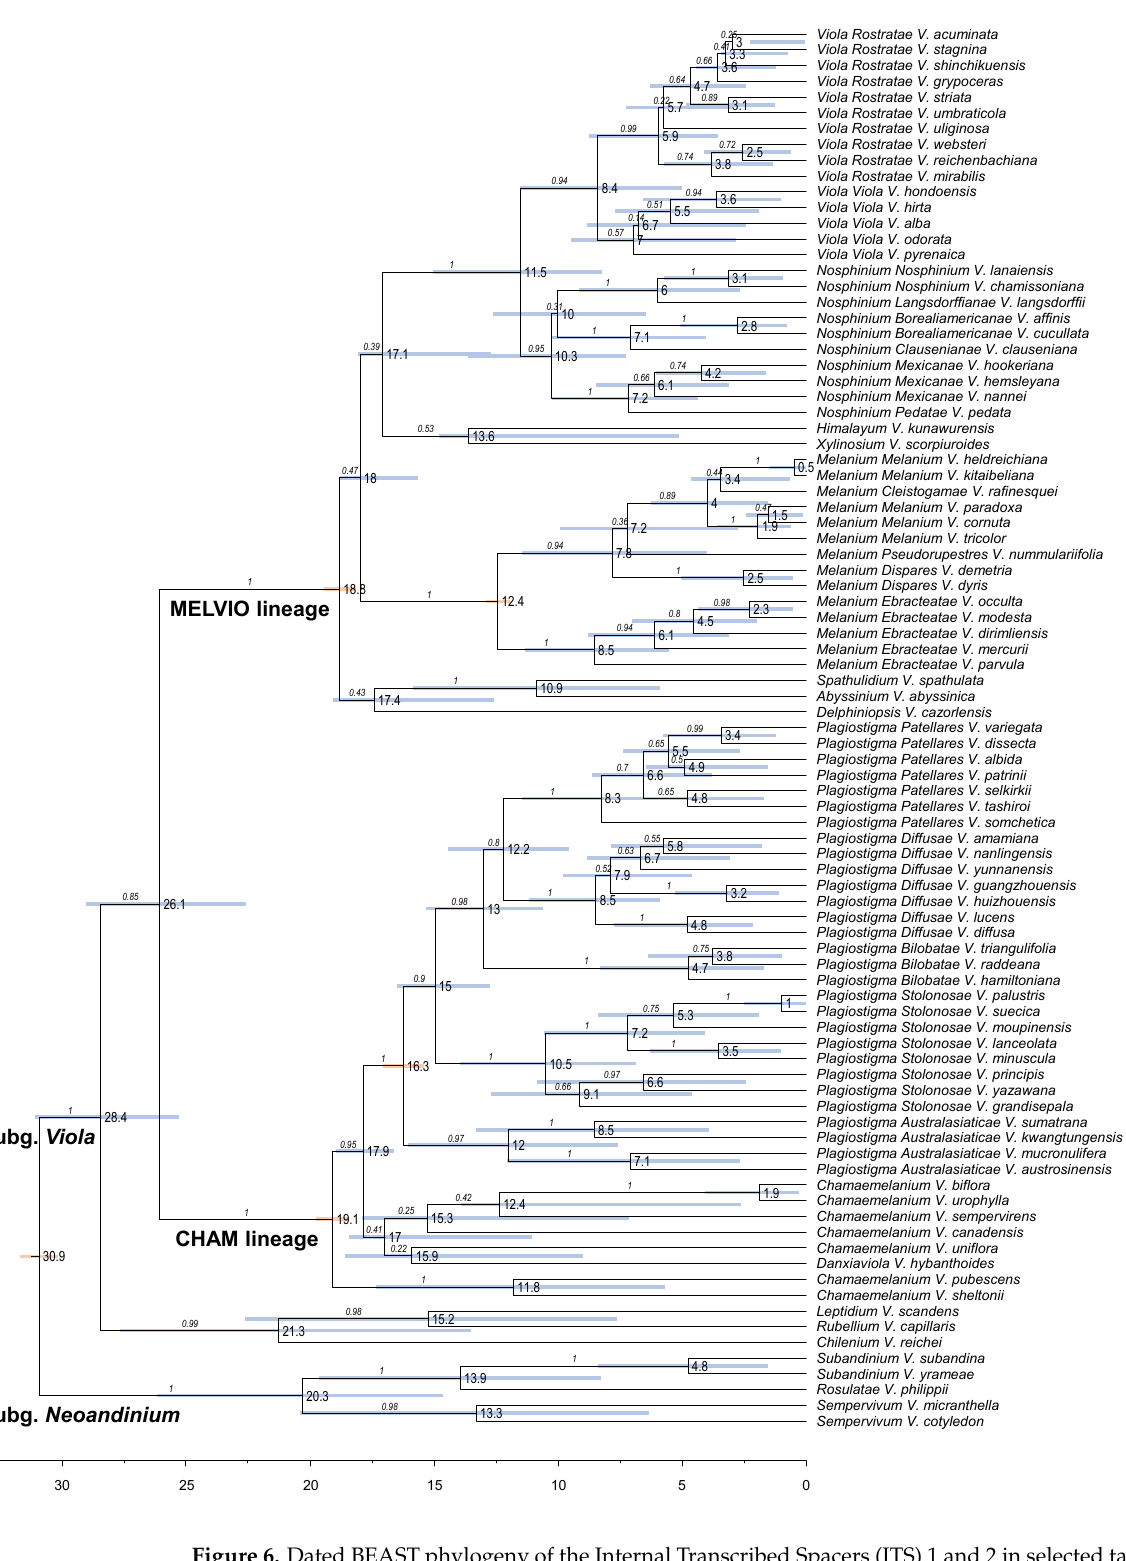
Figure 6. Dated BEAST phylogeny of the Internal Transcribed Spacers (ITS) 1 and 2 in selected taxa of Viola and secondary age calibration of five internal nodes. Tip names are shown as section, subsection (if available), and species. Node bars indicate the posterior 95% credibility interval for node height; nodes with bars indicated in brown were used for age calibration. Mean ages are indicated on nodes. The outgroup ( Melicytus ) was pruned.